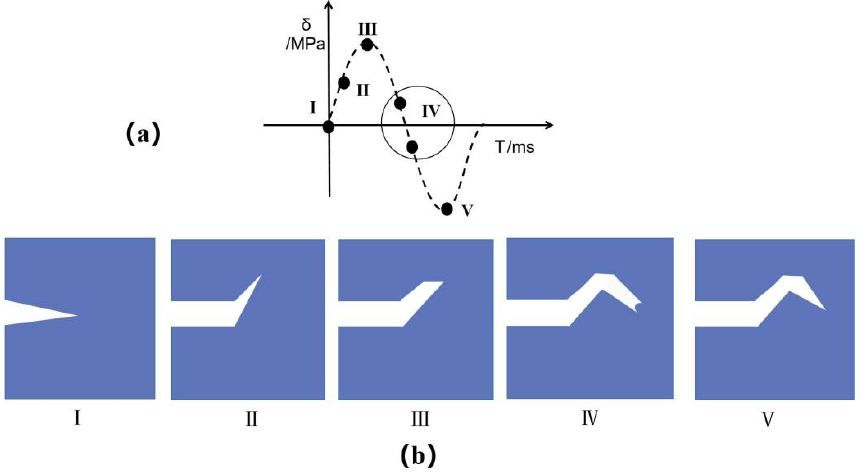
Figure 16. ( a ) Schematic diagram of cyclic stress, ( b ) Z-shaped expansion mechanism.